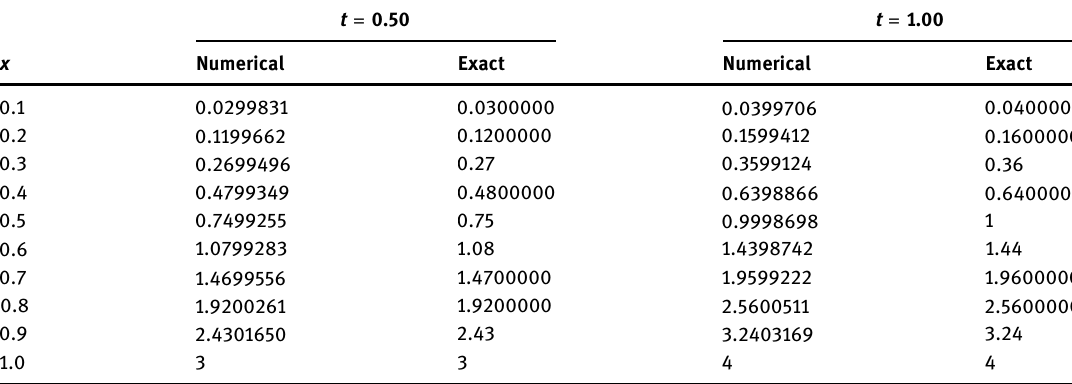
Table 12: U i j , and u i j , with α 0.75